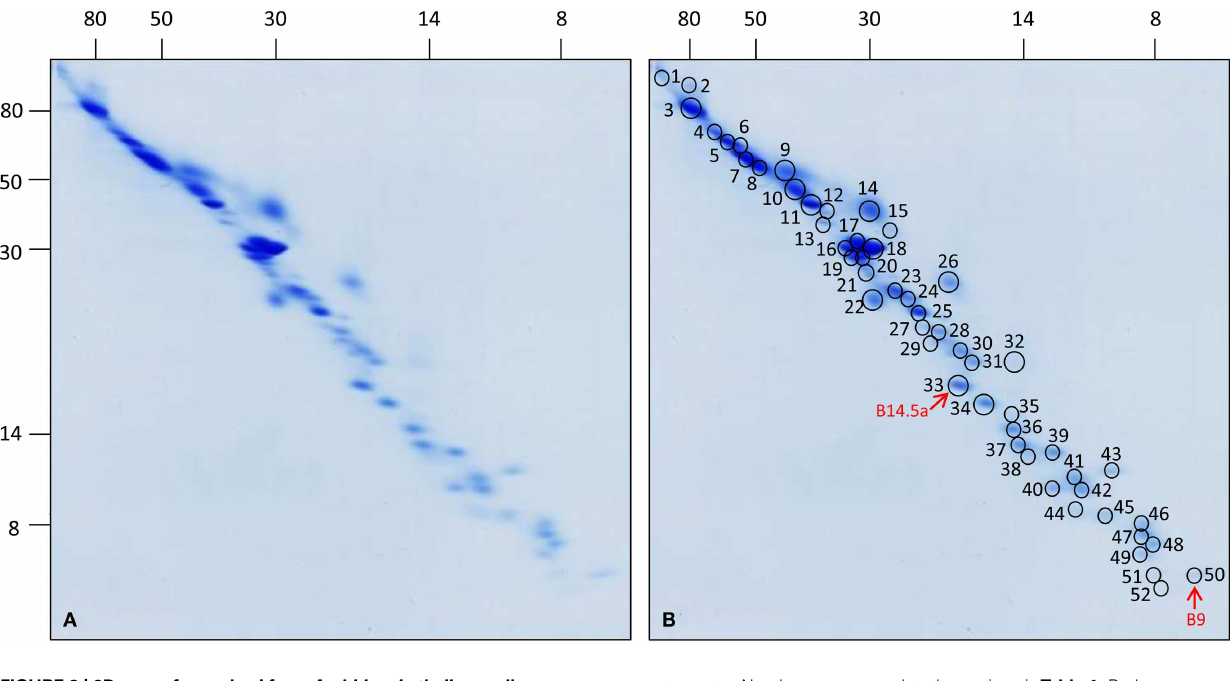
FIGURE 2 | 3D map of complex I from Arabidopsis thaliana cell culture .Total mitochondrial protein (1200 µ g each) was resolved by 3D BN/SDS/SDS-PAGE. (A) Coomassie-stained gel, (B) same gel as in (A) indicating protein spots which have been analyzed by mass